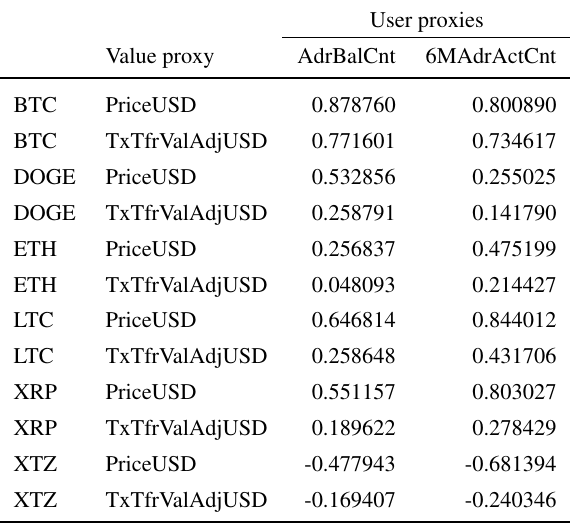
Table 3. Pearson correlation between value and user